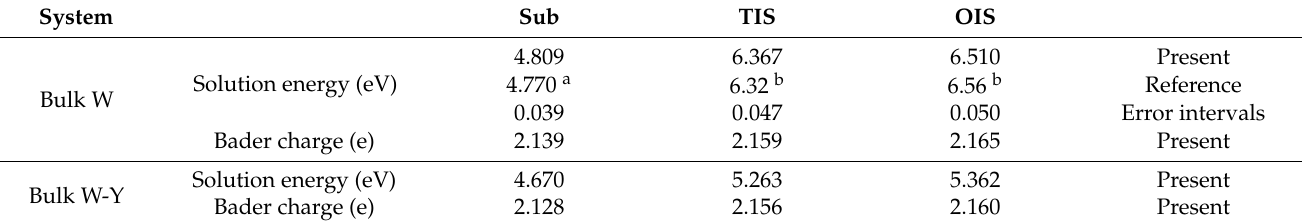
Table 1. Solution energy and Bader charge of He atoms at different occupied sites of W/W-Y systems.